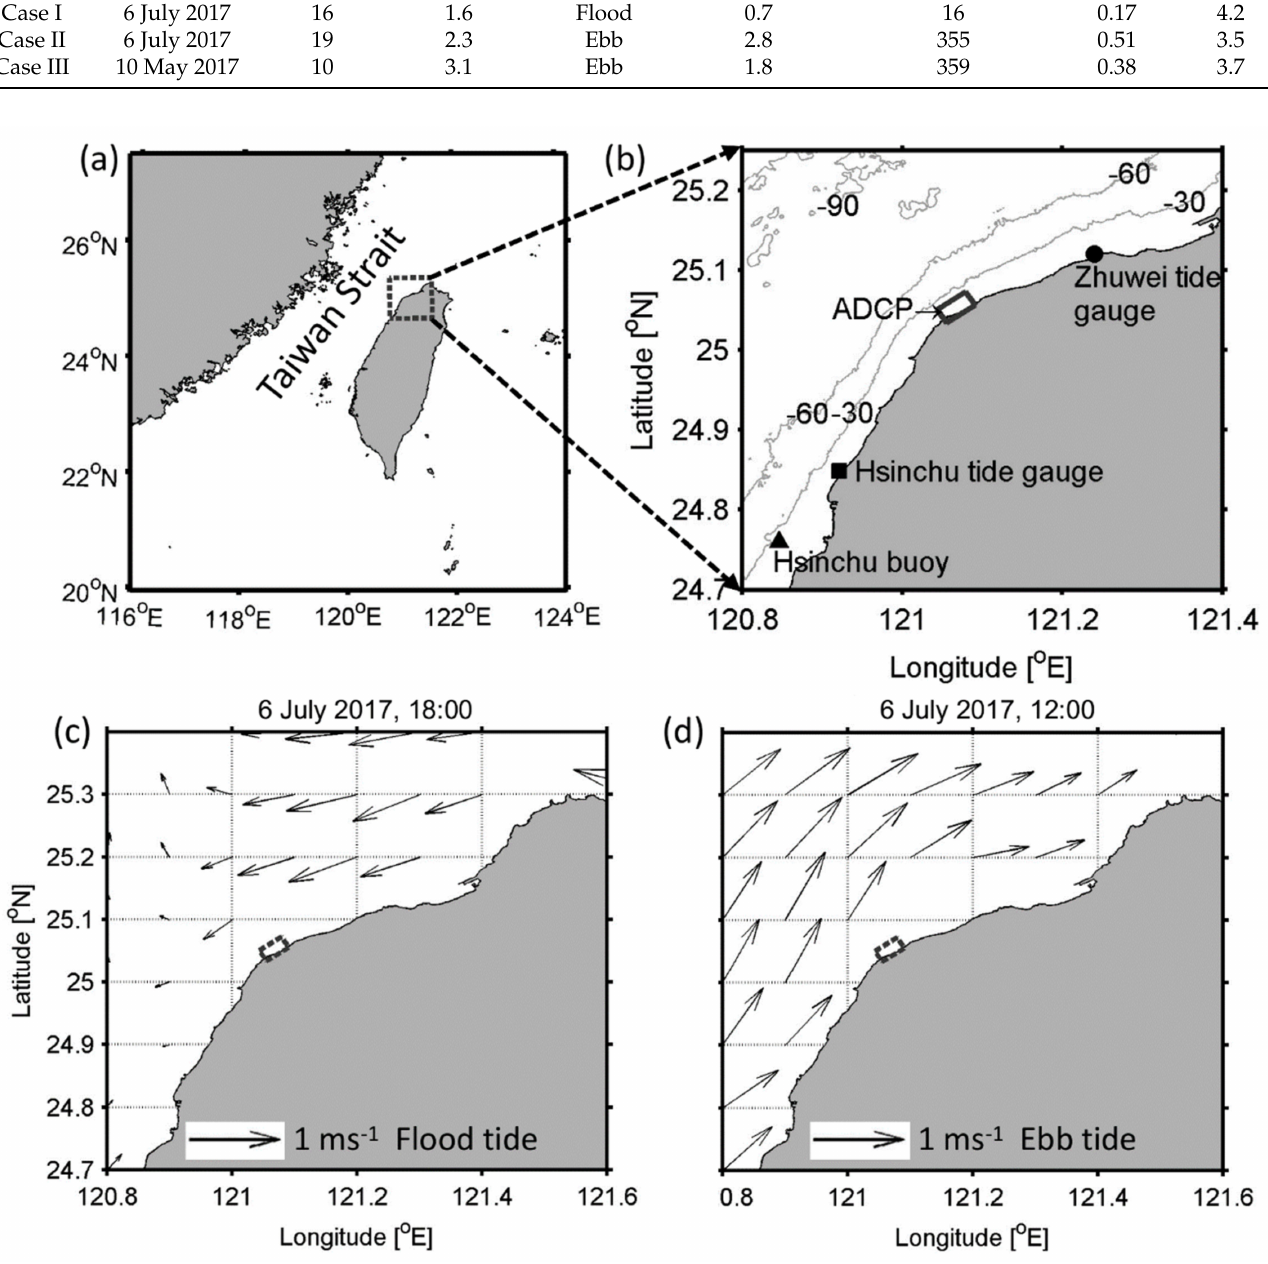
Figure 2. ( a ) Map of Taiwan Strait. ( b ) Locations of Zhuwei tide gauge ( • ), upward-looking ADCP ( → ), and Hsinchu tide gauge ( (cid:4) ), and Hsinchu data buoy ( (cid:78) ) along the coastline. The contour indicates the water depth (m). The sea-surface current field with a 10 km spatial resolution was observed by high-frequency radar during the flood tide ( c ) and ebb tide ( d ) on 6 July